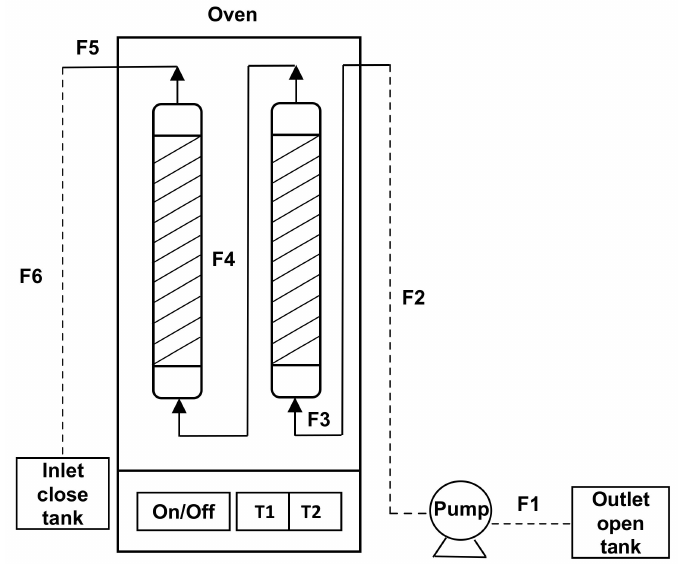
Figure 7. Continuous packed bed reactor. F1 and F2 feed flow, C-FLAX tubing. F3 feed flow, stainless steel piping; F3 feed flow, stainless steel piping; F4 transesterification product, stainless steel piping; F5 transesterification product, stainless steel piping; F6 transesterification product, C-FLAX tubing; T1 temperature for inlet the PBR; T2 temperature for outlet the PBR.